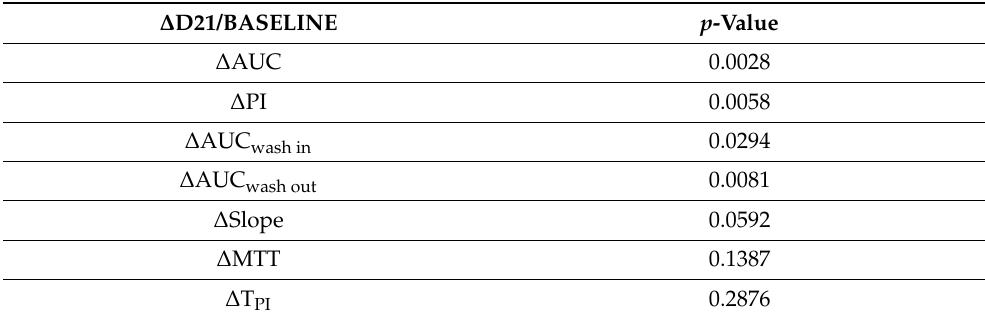
Table 3. Significance level ( p -value) of the association between changes in perfusion parameters values between baseline and D21 and overall survival.